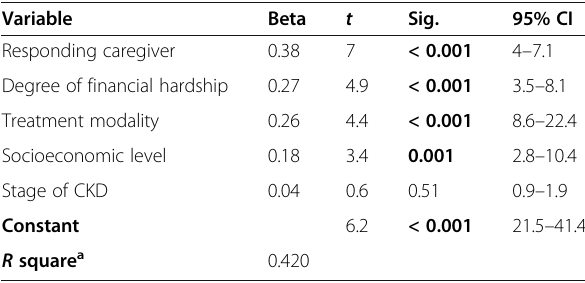
Table 5 Predictors of total PedsQL ™ Family Impact